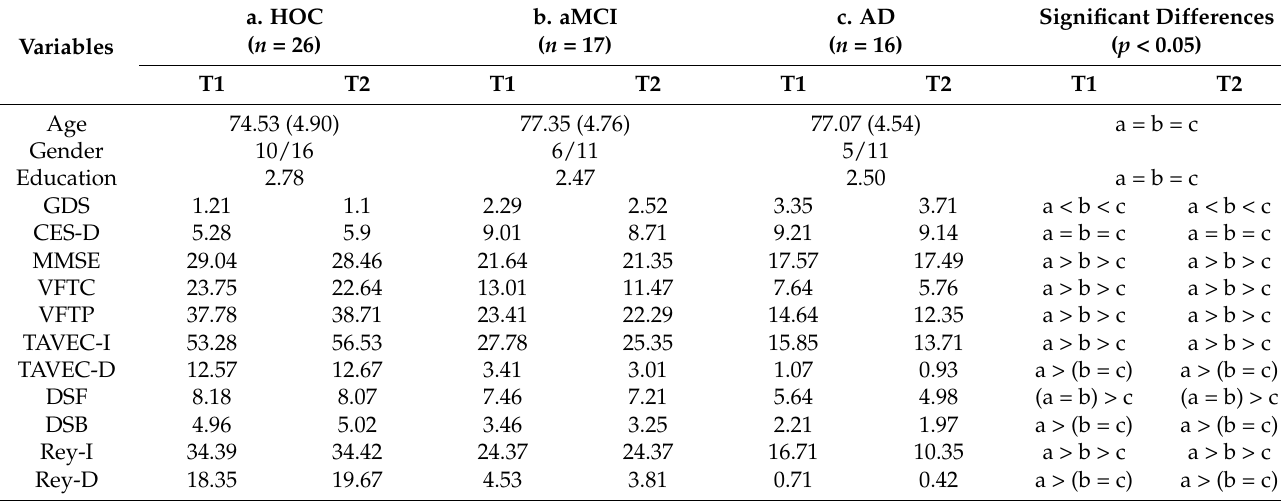
Table 1. Mean scores (and standard deviations) for demographic and neuropsychological variables obtained at Time 1 and Time 2 by the different study